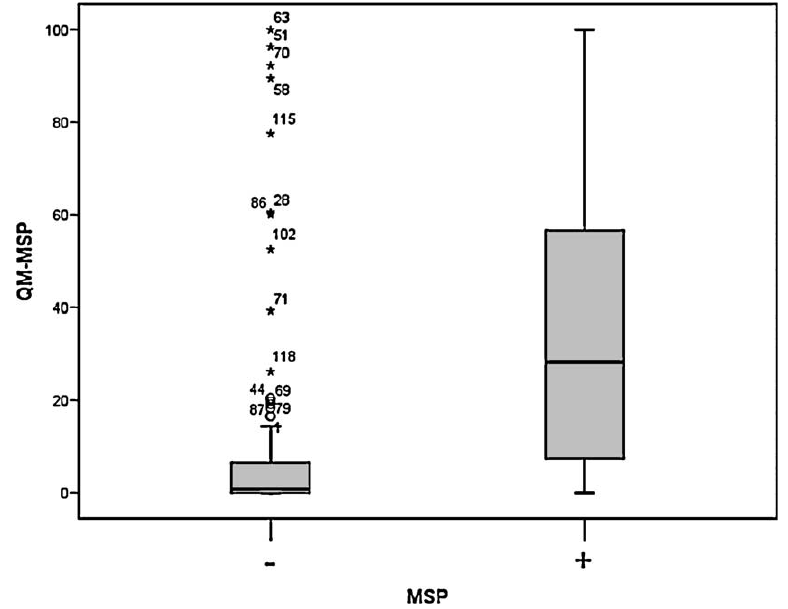
Fig. 1. Boxplot of methylation detection by QM-MSP versus MSP in breast cancer specimens ( n = 40). The boxplot shows median (–), interquartile range (I) and outliers ( ◦ / ∗ ). The left plot shows the range of QM-MSP values (for DNA from paraffin-embedded tissue) for the samples that did not show a methylation band in MSP, the right panel shows the range for samples that did show a band in